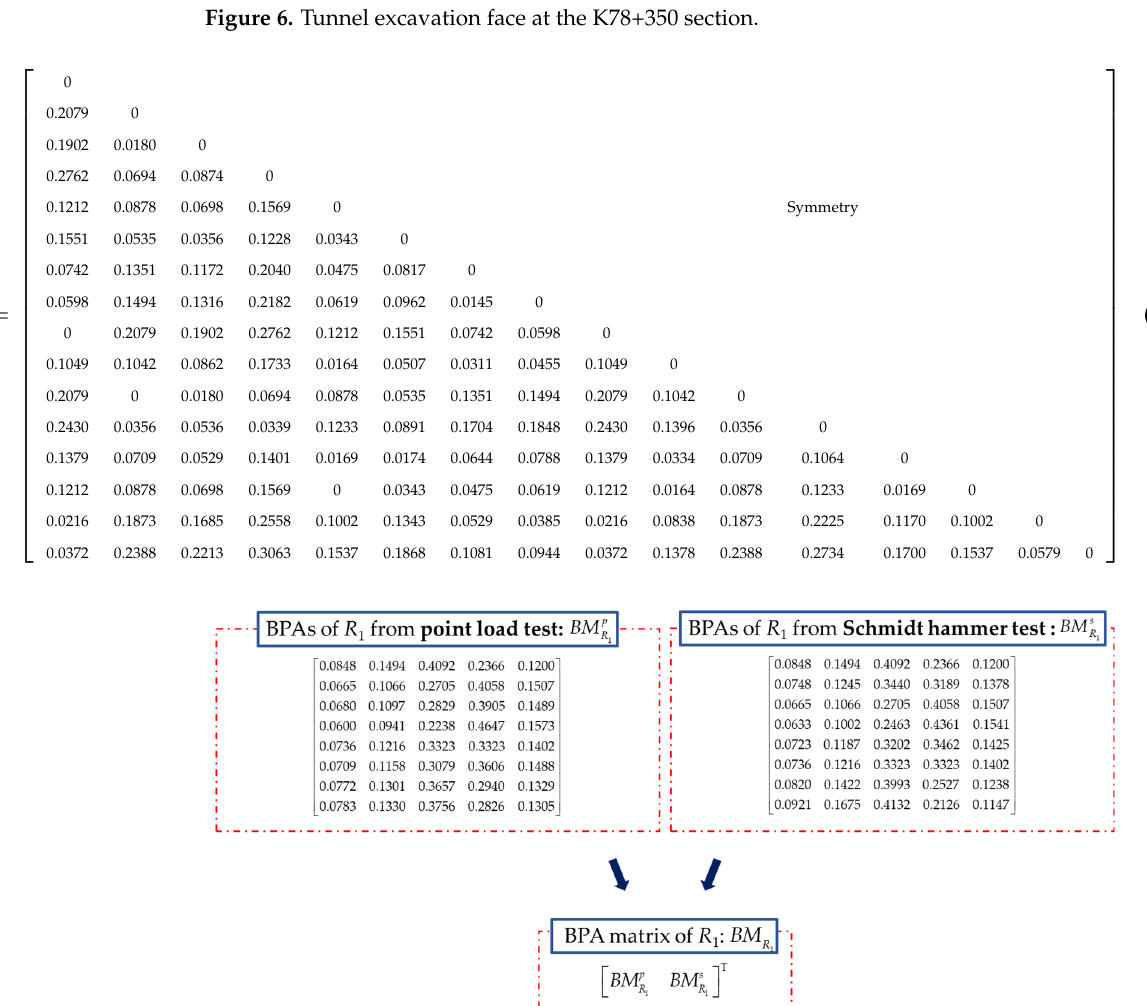
Figure 7. Constructed with BPAs of R 1 .